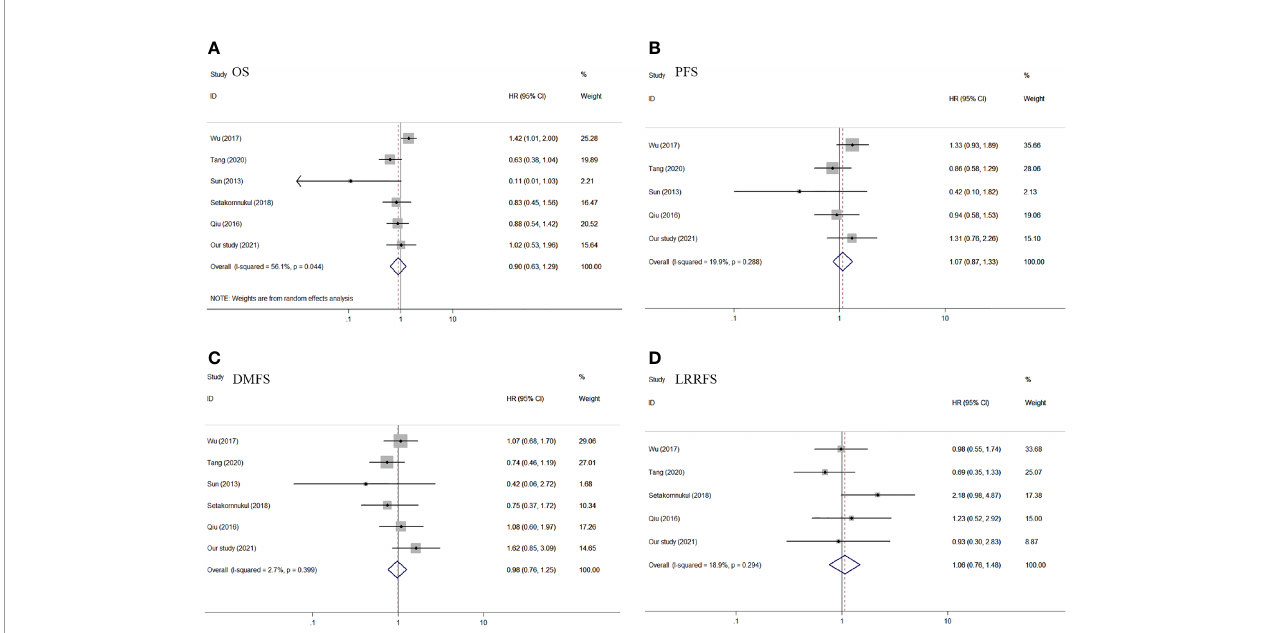
FIGURE 4 | Forest plot of OS (A) , PFS (B) , DMFS (C) , and LRRFS (D) of the included studies. OS, overall survival; PFS, progression-free survival; DMFS, distant metastasis-free survival; LRRFS, locoregional relapse-free